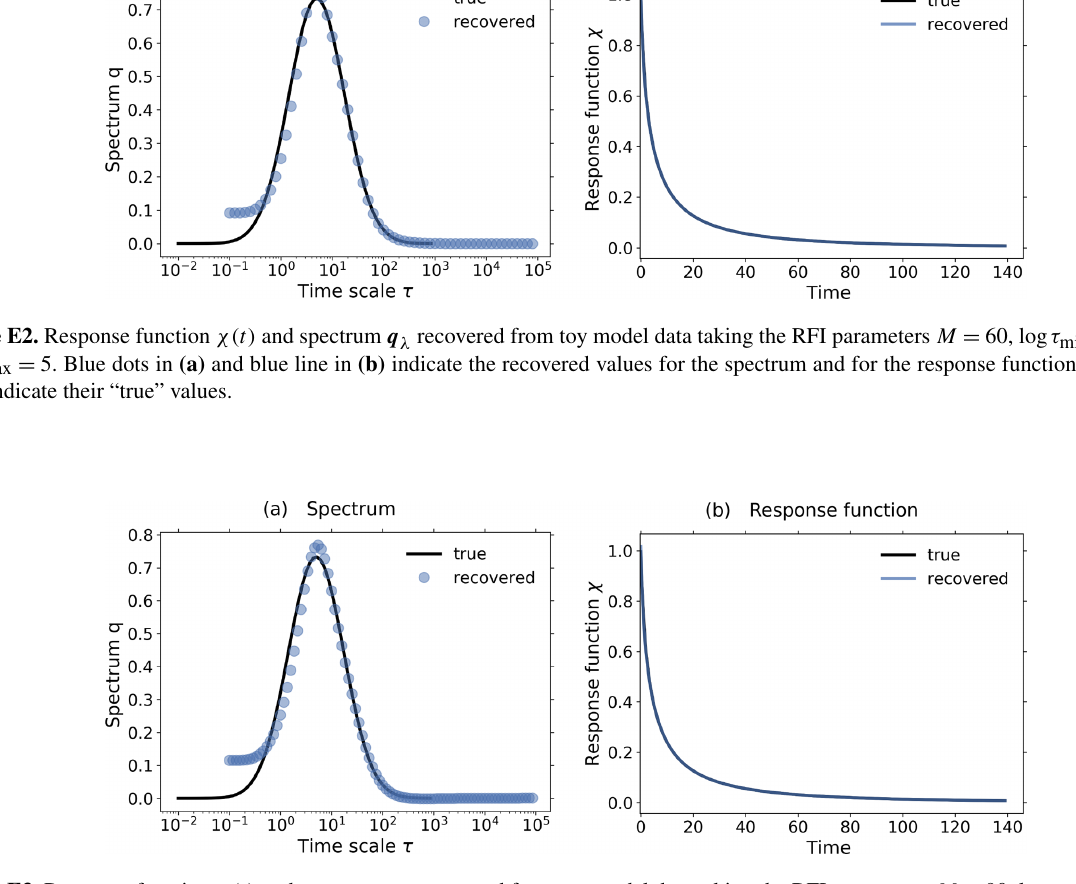
Figure E3. Response function χ(t) and spectrum q λ recovered from toy model data taking the RFI parameters M = 90, log τ min = − 1, and log τ max = 5. Blue dots in (a) and blue line in (b) indicate the recovered values for the spectrum and for the response function, while black lines indicate their “true”